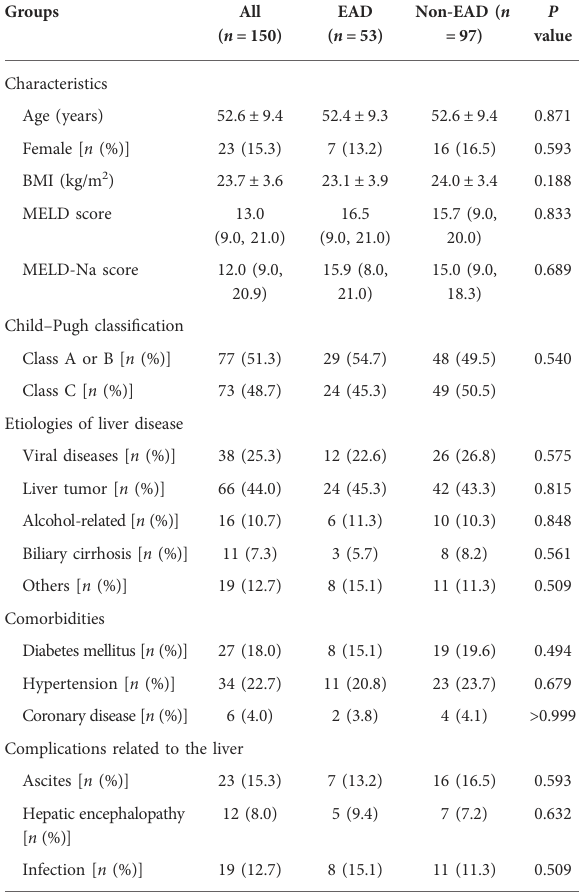
TABLE 1 Characteristics of EAD and non-EAD patients.